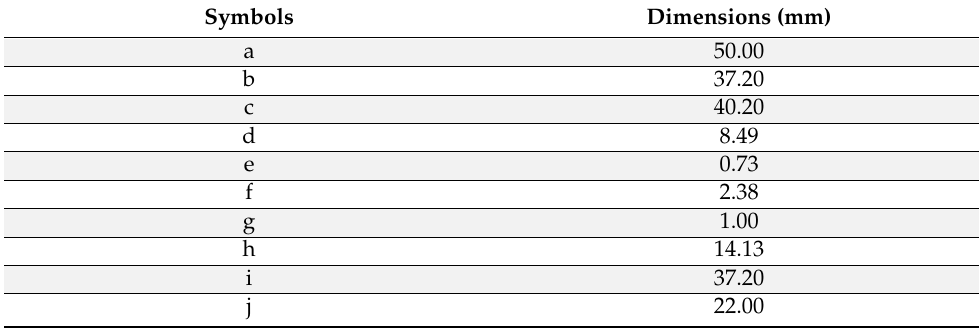
Table 2. The dimensions of the proposed meander line monopole antenna.